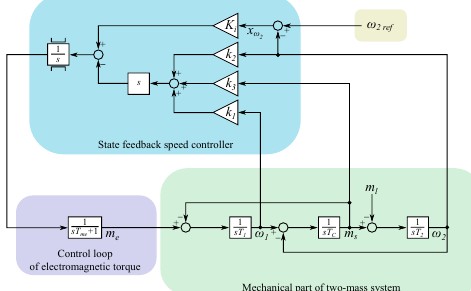
Figure 1. Block diagram of two-mass system with state feedback speed